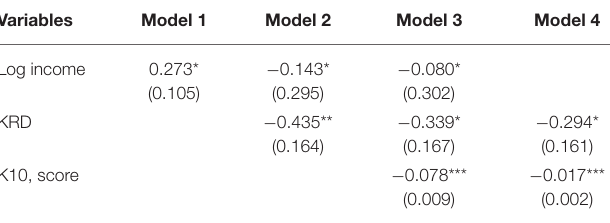
TABLE 2 | Relationship between relative deprivation and SRH in urban older populations (select results) a,b,c .